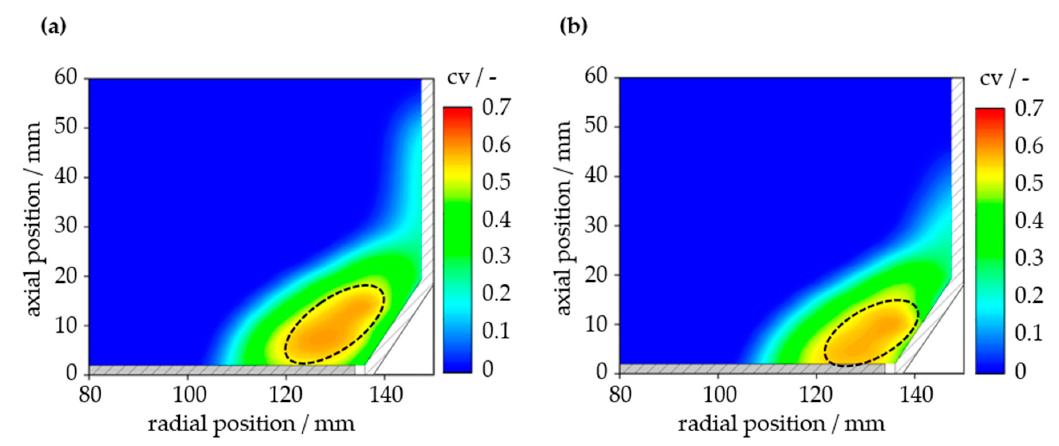
Figure 5. Time-averaged solid volume fraction for the dry case ( a ) and for the wet case ( b ).